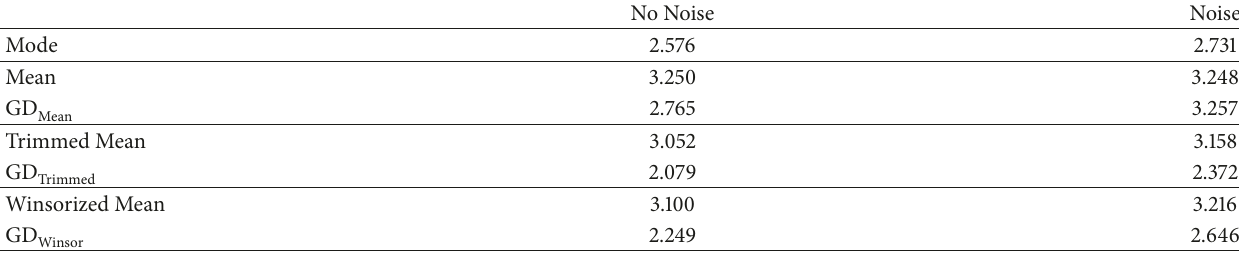
Table 76: Log-normal distributions with heteroscedastic noise. The noise has zero mean and a standard deviation s equal to 50% of the value of the data. The noise is composed of 1000